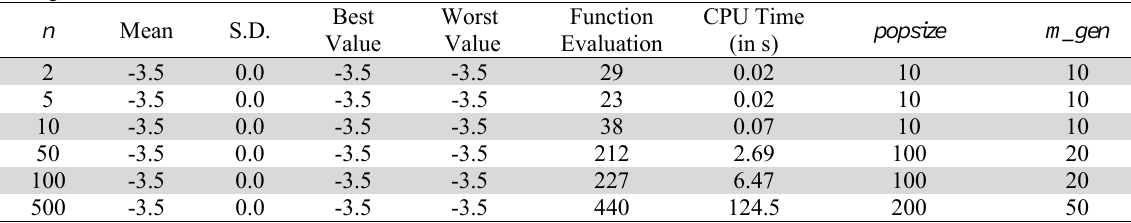
Computational Results of Problem -6